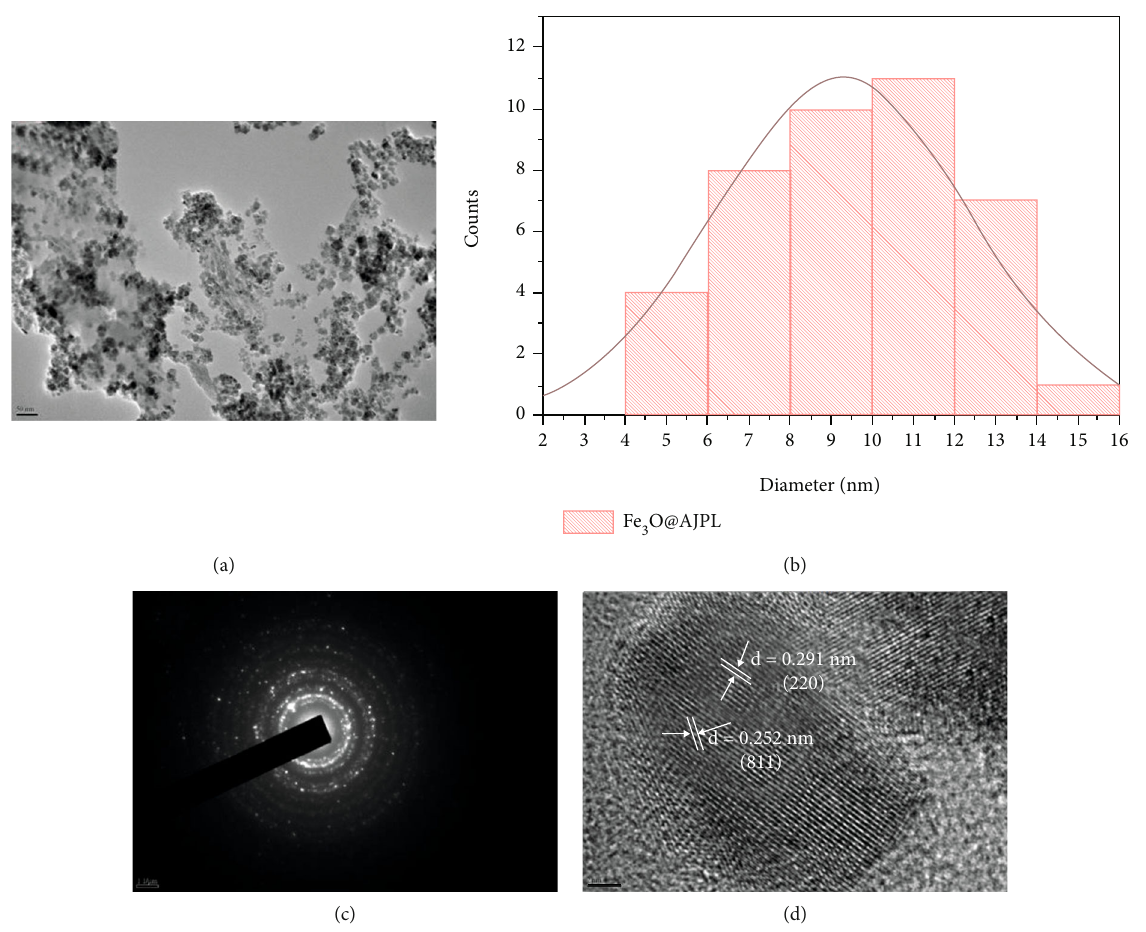
Table 1: Adsorption selectivity experiments with dye solutions (conditions: dye — 20mg/L, time — 24 h, Fe volume — 0.05L, temperature — 25 ° C, and agitation — 100rpm).